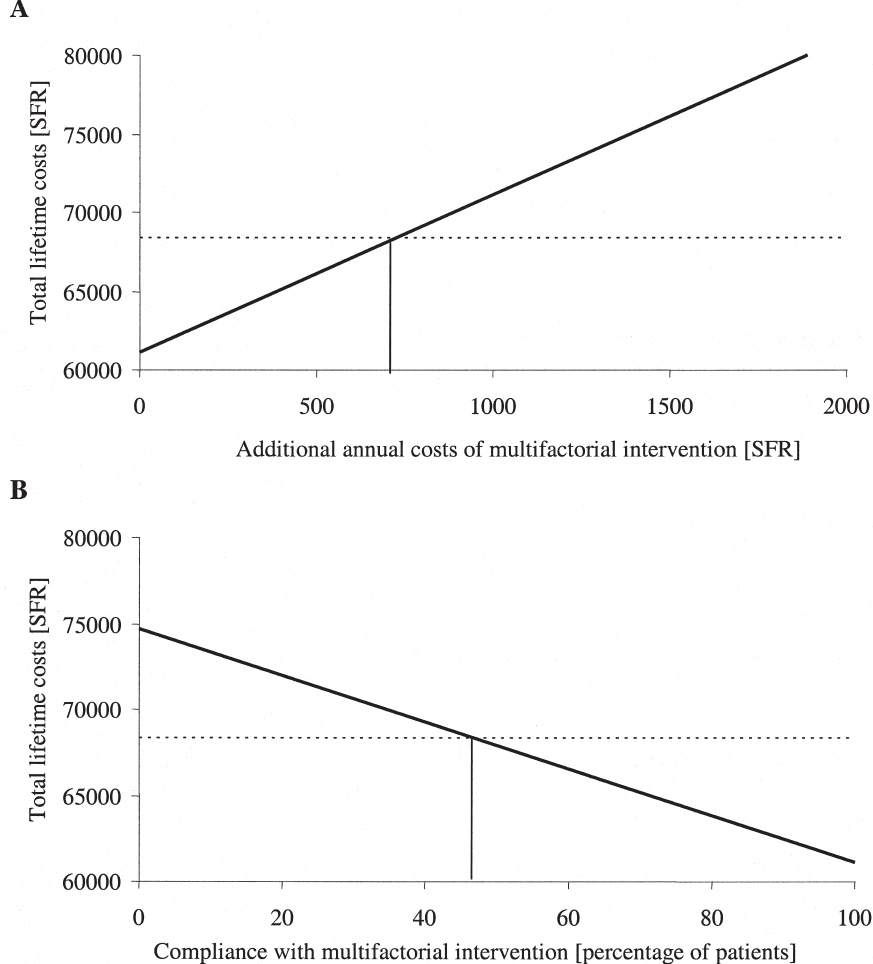
Alternative disease management strategies for secondary prevention in typ 2 diabetes